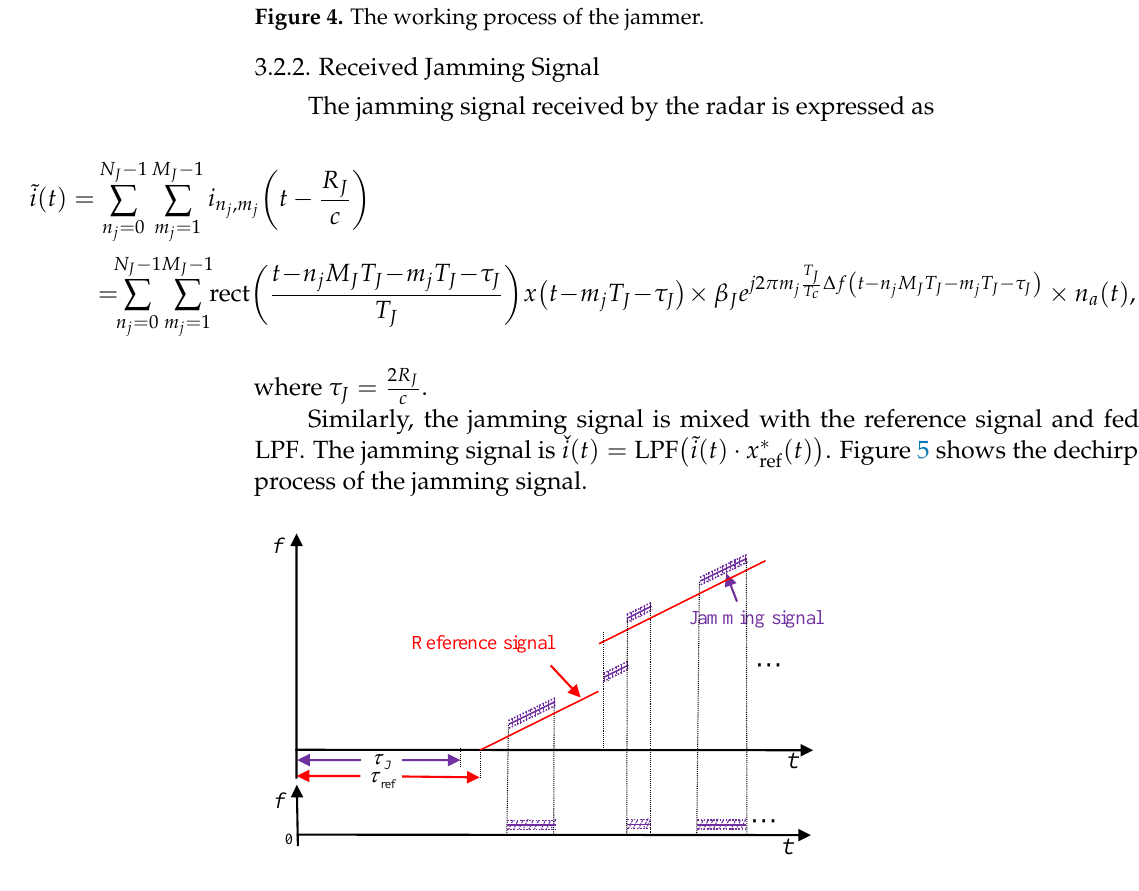
Figure 5. The jamming signal processing